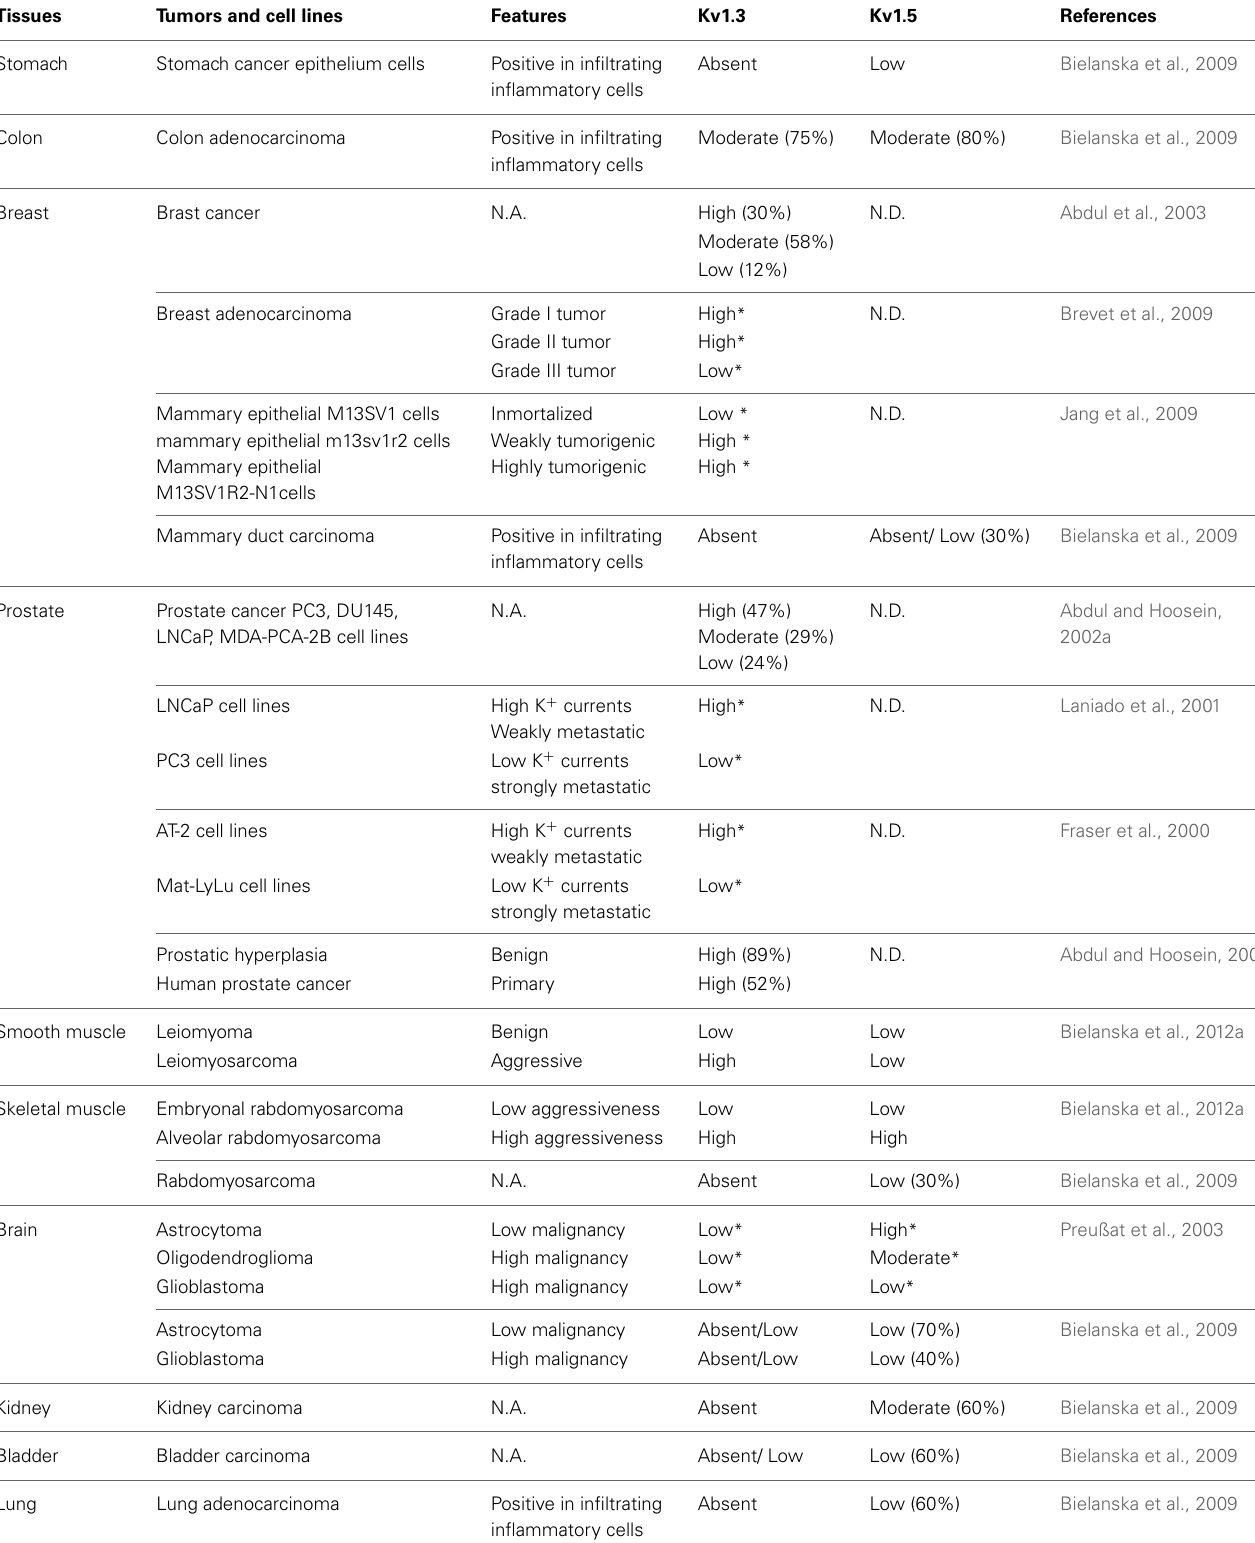
Table 1 | Expression of Kv1.3 and Kv1.5 in solid cancers and tumoral cells.